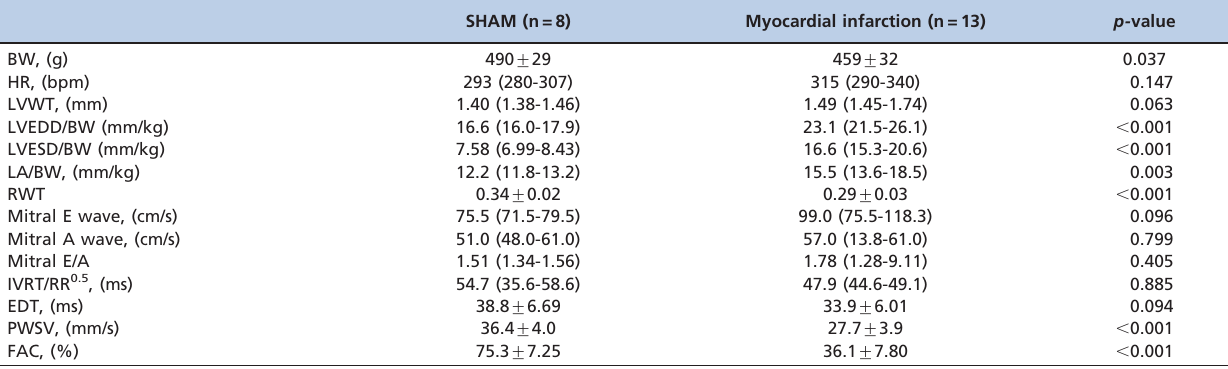
Table 1 - Echocardiographic